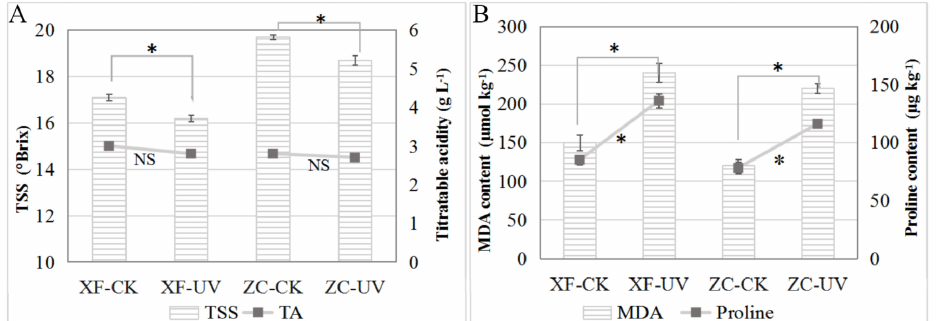
Figure 1. Effect of post-harvest UV-C application on the content of total soluble solids (TSS), titratable acid (TA), malondialdehyde (MDA), and proline in grape berries. ( A ) Comparison of TSS and TA contents in ‘Xiangfei’ and ‘Zicui’ berries under different treatments. The bar graph represents the difference in TSS content, and the line graph represents the difference in TA content. The error bars represent standard deviations of the means. The asterisk indicates significant differences ( p < 0.05, t -tests), while NS means that the difference is not significant. XF represents ‘Xiangfei’ and ZC represents ‘Zicui’. CK represents the control dark treatment while UV represents the UV-C treatment. The same below follows. ( B ) Comparison of MDA and proline contents in ‘Xiangfei’ and ‘Zicui’ berries under different treatments. The bar graph represents the difference in MDA content, and the line graph represents the difference in proline